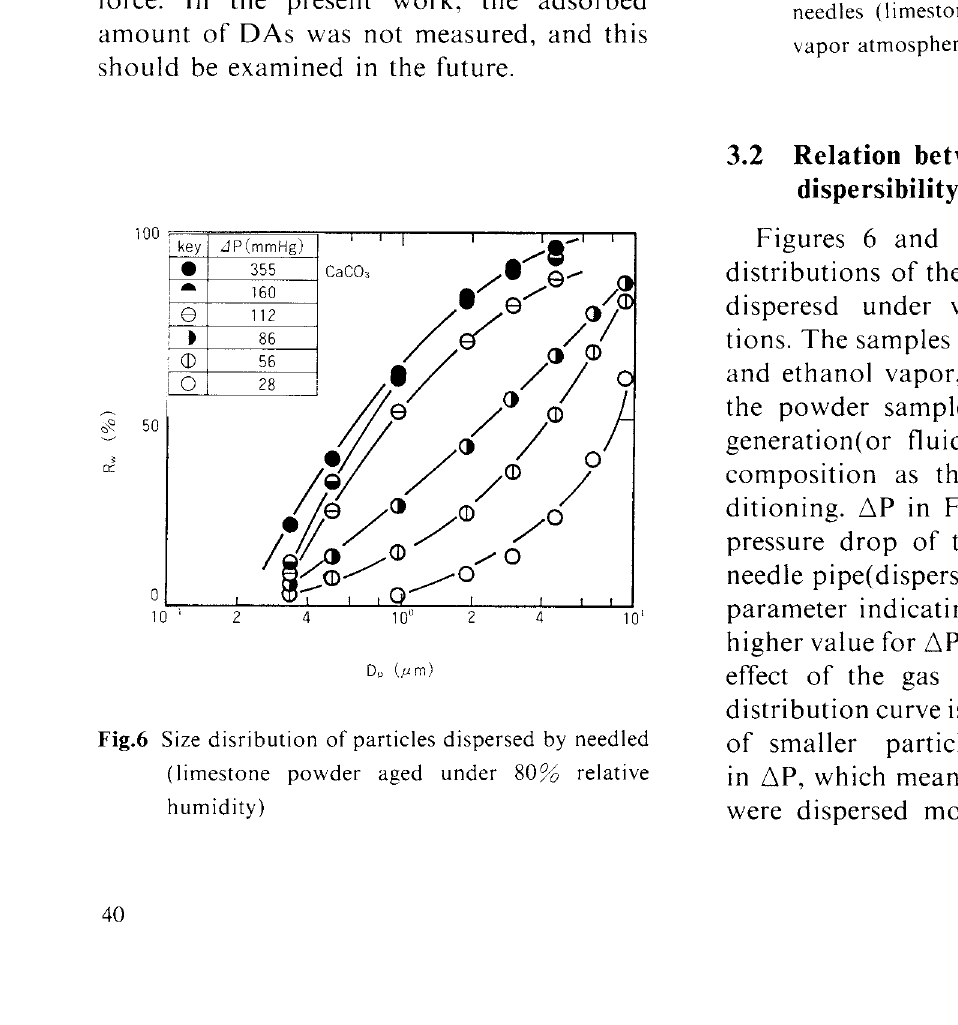
Fig.7 Size distribution oflivestone particles dispersed by needles (limestone powder aged under ethanol vapor